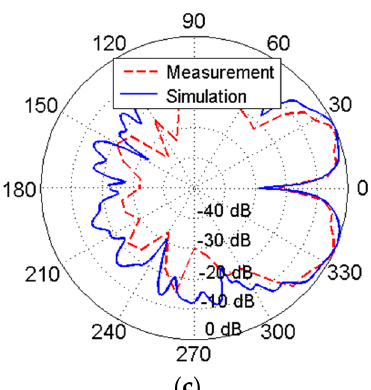
Figure 16. Measured and simulated far-field radiation pattern of the antenna system while exciting port 1 with ( a ) V 1 = 0 V and V 2 = 20 V, ( b ) V 1 = 20 V and V 2 = 10 V, ( c ) V 1 = V 2 = 20 V.